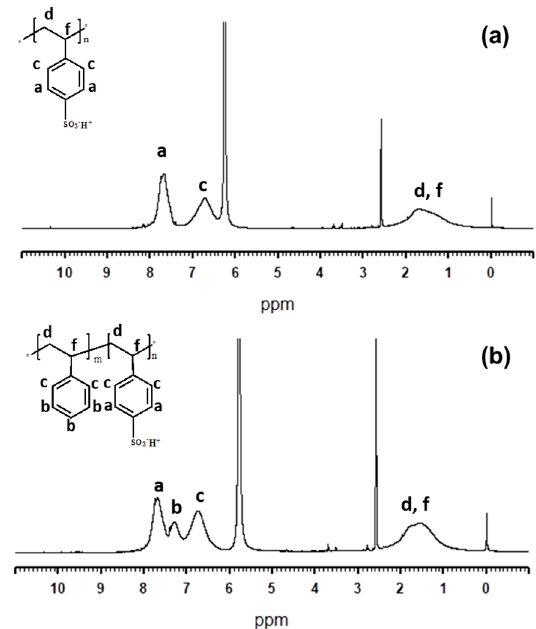
Figure 1. 1 H NMR spectra of ( a ) PSS and ( b )